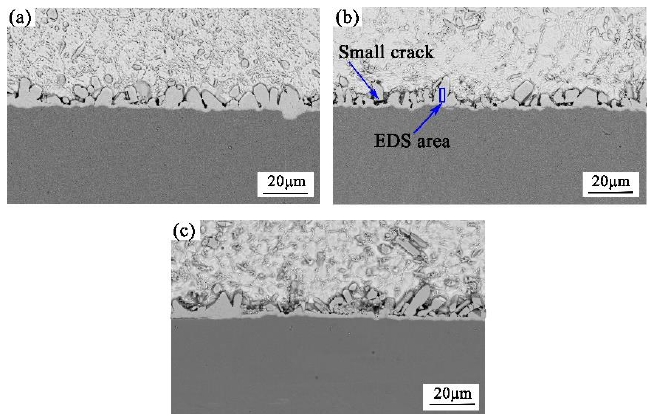
Figure 5. Interface SEM morphology of Sn2.5Ag0.7Cu0.1RE0.05Ni/Cu solder joint after thermal cycles.